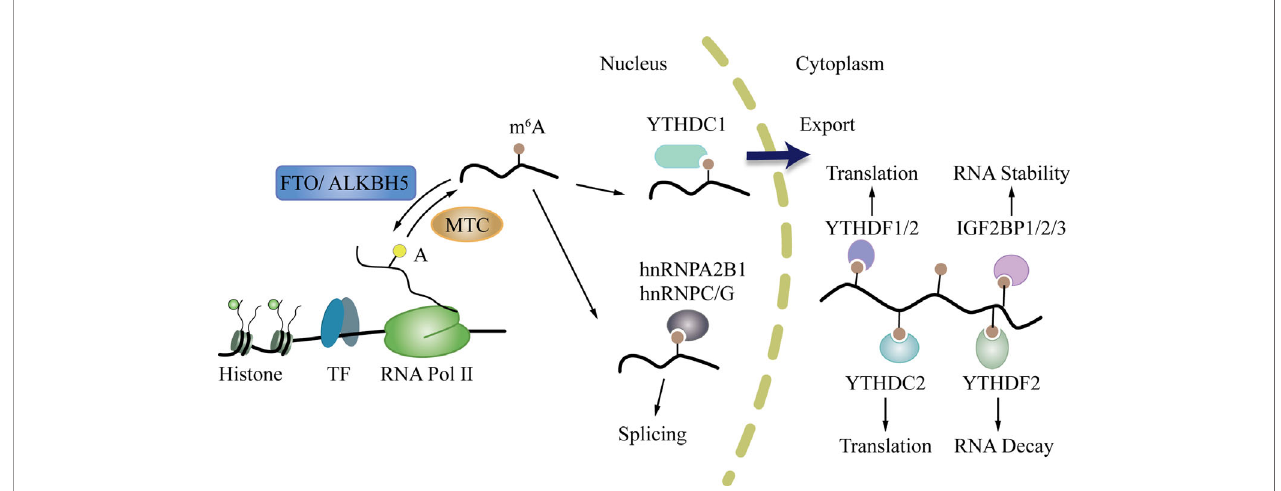
FIGURE 2 | The life cycle of m 6 A mRNA. First, m 6 A writers and erasers regulate the change of m 6 A during transcription in the nucleus. After that, m 6 A can bind to speci fi c nuclear readers, and in fl uence mRNA splicing, exporting, and other bioprocesses. Then, m 6 A is exported to the cytoplasm where it binds to cytoplasm readers and in fl uences mRNA decay, translation, and